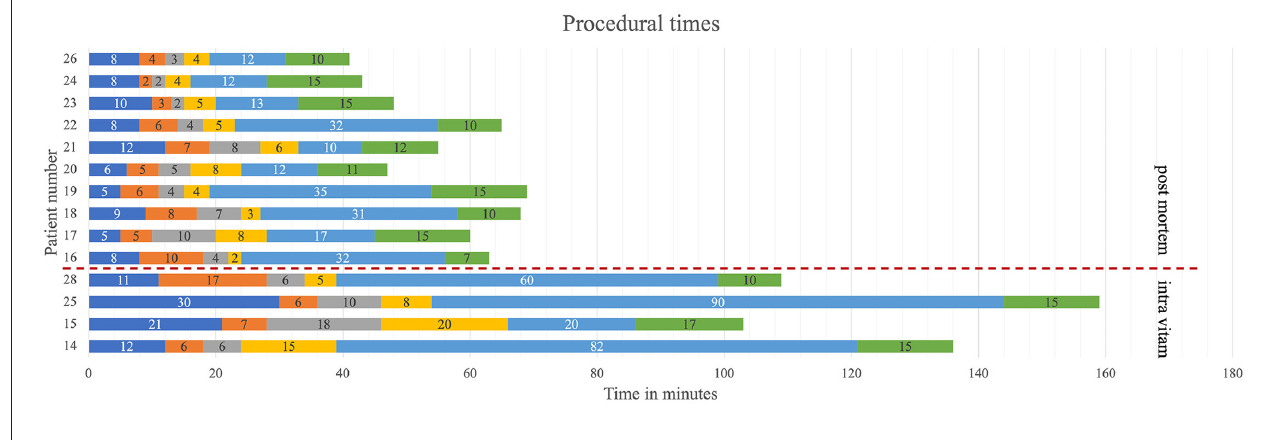
FIGURE 5 | Procedural time intervals with color coding (dark blue planning, yellow needle alignment, light blue interrupted red